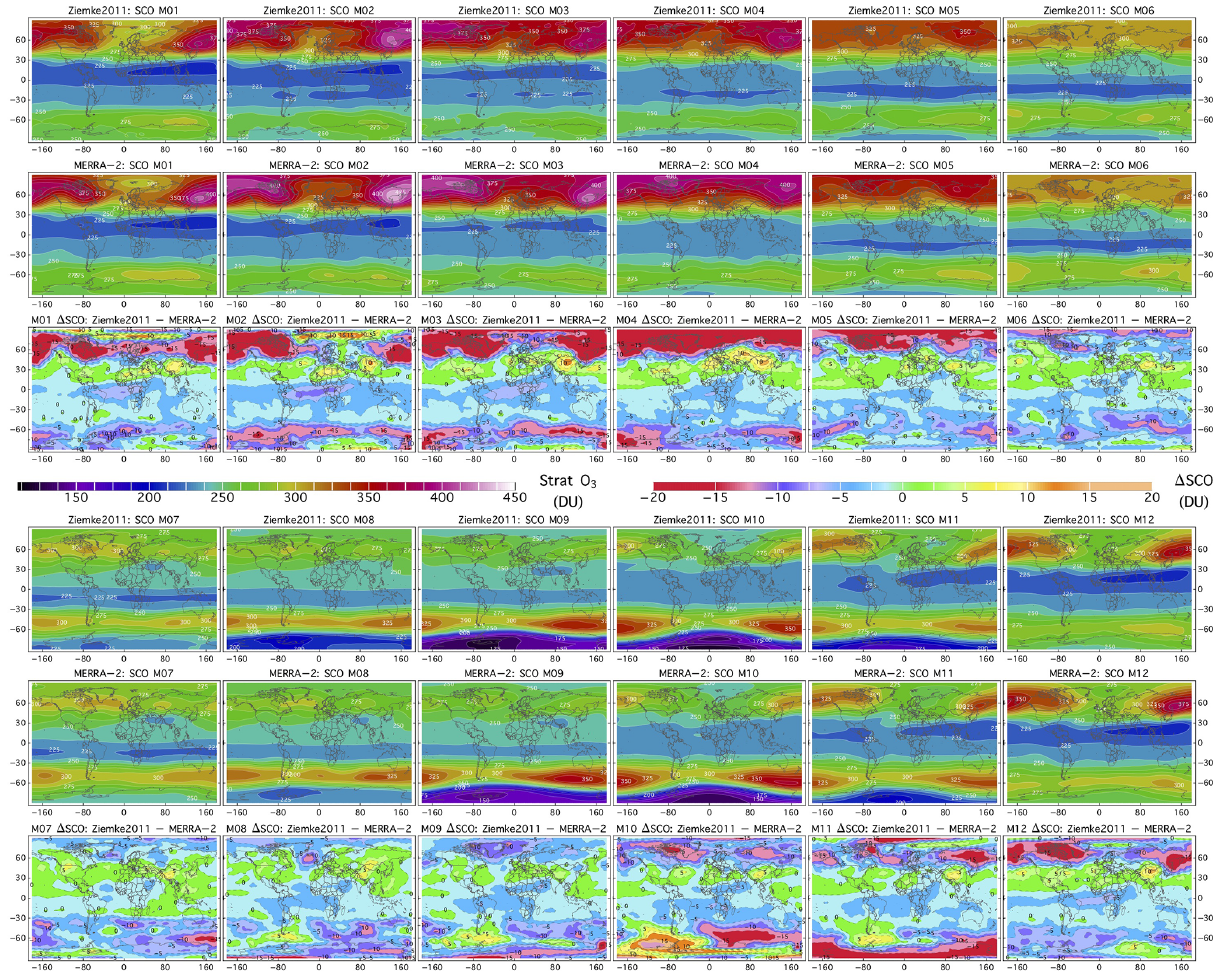
Figure 11. Climatological stratospheric column O 3 (SCO) maps from MERRA-2 and Ziemke et al. (2011) for the 12 months (January–June, upper panels; July–December, lower panels) of the year and their